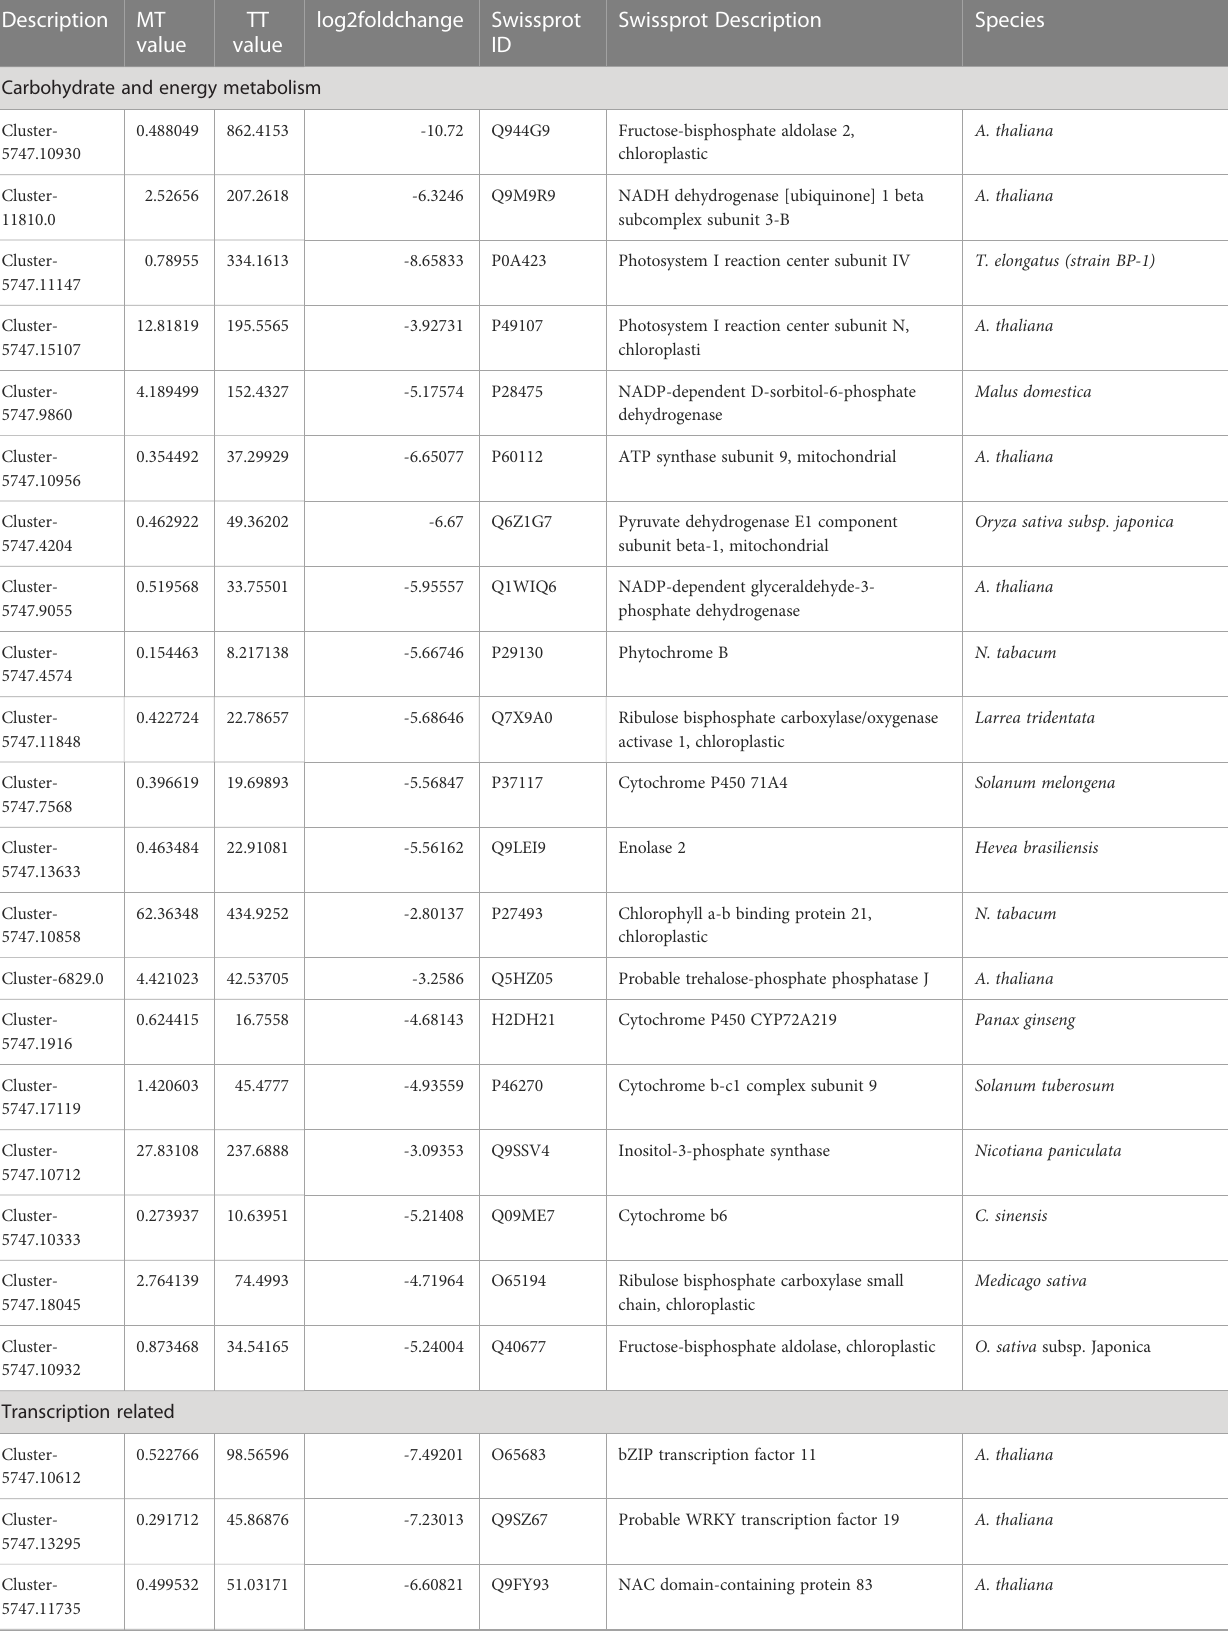
TABLE 2 Differentially expressed genes in tolerant Turpentine (TT) and susceptible Mylepelian (MT) mango genotypes after salt